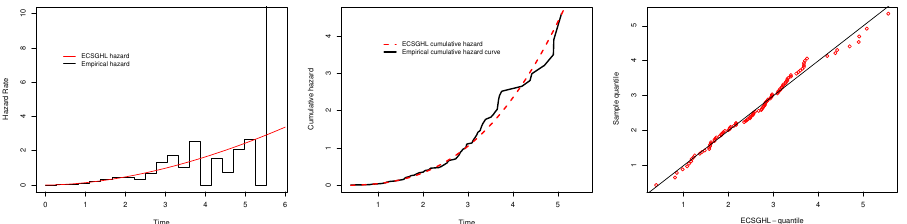
Figure 17. Plots of the empirical and estimated hrf, the empirical and estimated chrf, and QQ plot of the ECSGHL model for real data II.